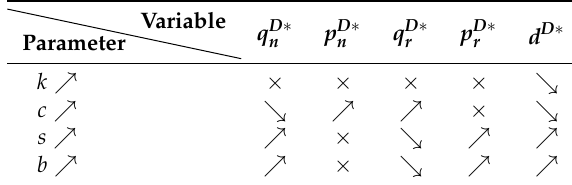
The signs (cid:37) , (cid:38) and × represent the relationships as being monotonic increasing, monotonic decreasing and unrelated with respect to the parameter,